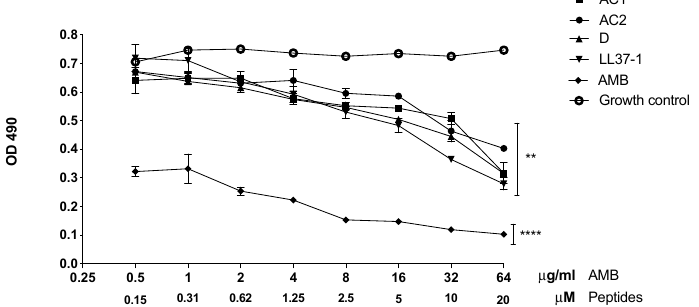
Figure 6. Effect of LL-37 analog peptides on C. albicans ATCC 10231 biofilm formation. Colorimetric reaction was read spectrophotometrically at 490 nm. Statistical difference (** p < 0.01) was observed in yeasts treated with 20, 10, 5, and 2.5 µM of the derived peptides. At 1.25 and 0.62 µM concentrations, the statistical significance was **** p < 0.0001 compared to the growth control (yeasts without exposure to the antimicrobial peptides).